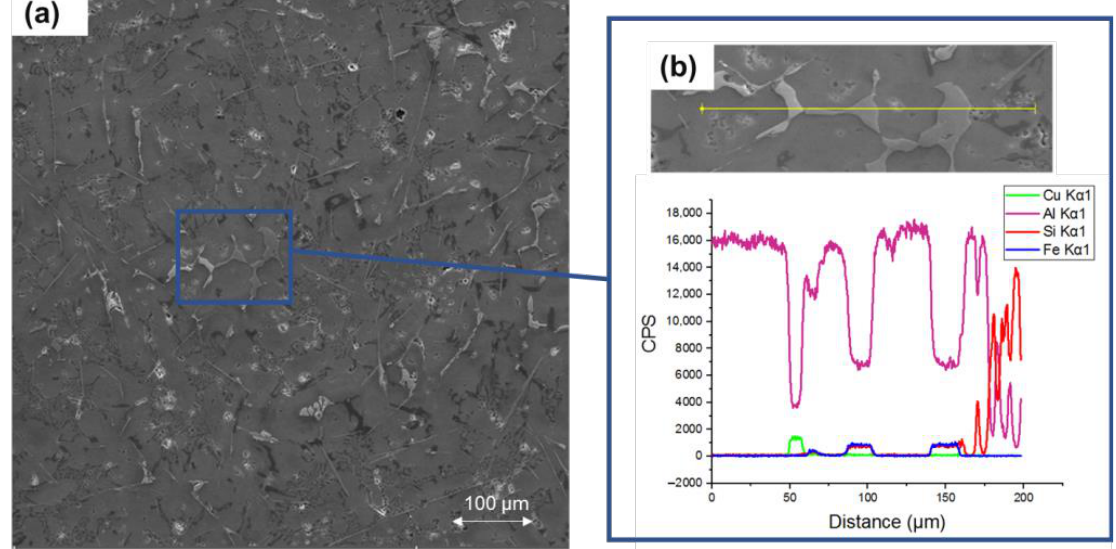
Figure 3. ( a ) A332 Secondary electron image of Chinese-script phase with; ( b ) corresponding EDS line scan showing the elements of this phase 200× present in the sample without grain refiner.